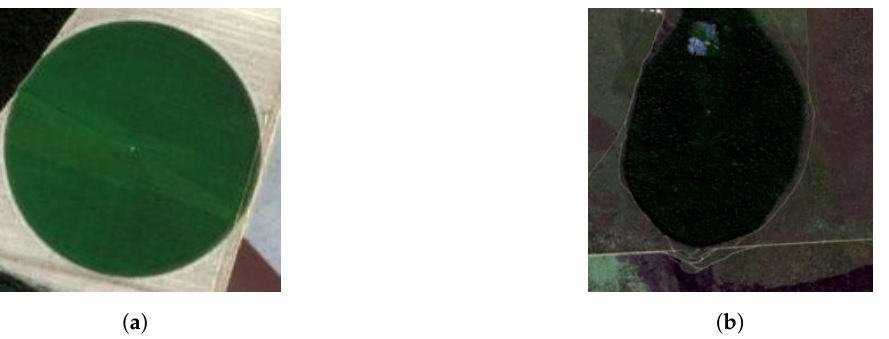
Figure 8. Examples of training samples for GoogLeNet. ( a ) A sample image of center pivot irrigation systems. ( b ) A sample image of non-center pivot irrigation